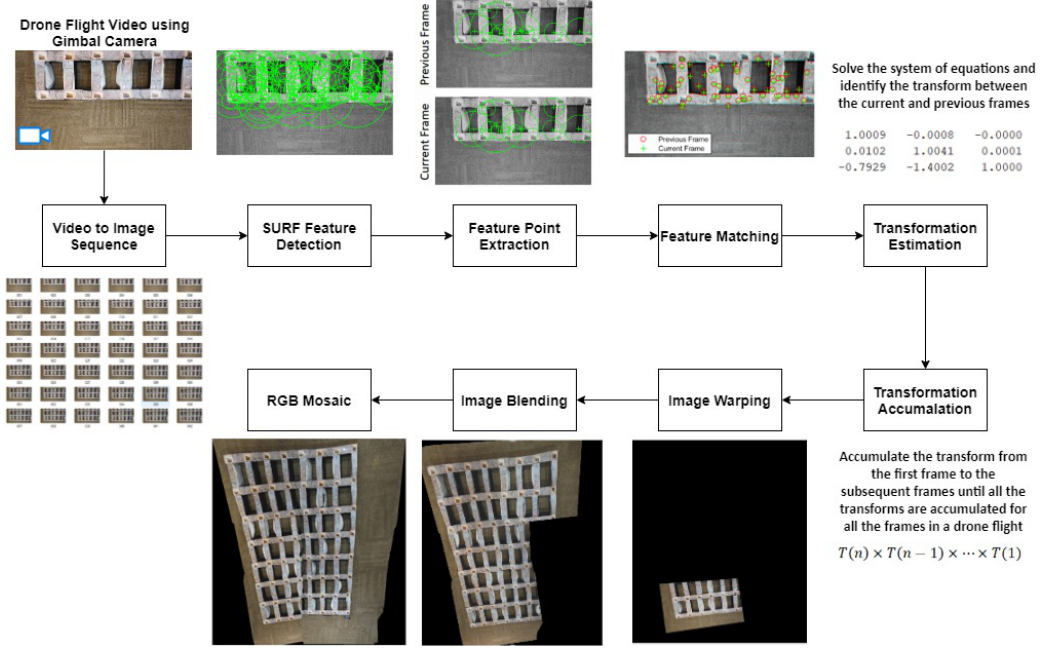
Figure 6. Full pipeline for the proposed mosaicking algorithm using RGB flight video.